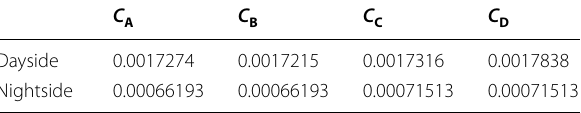
Table 5 Smear noise correction coefficients for